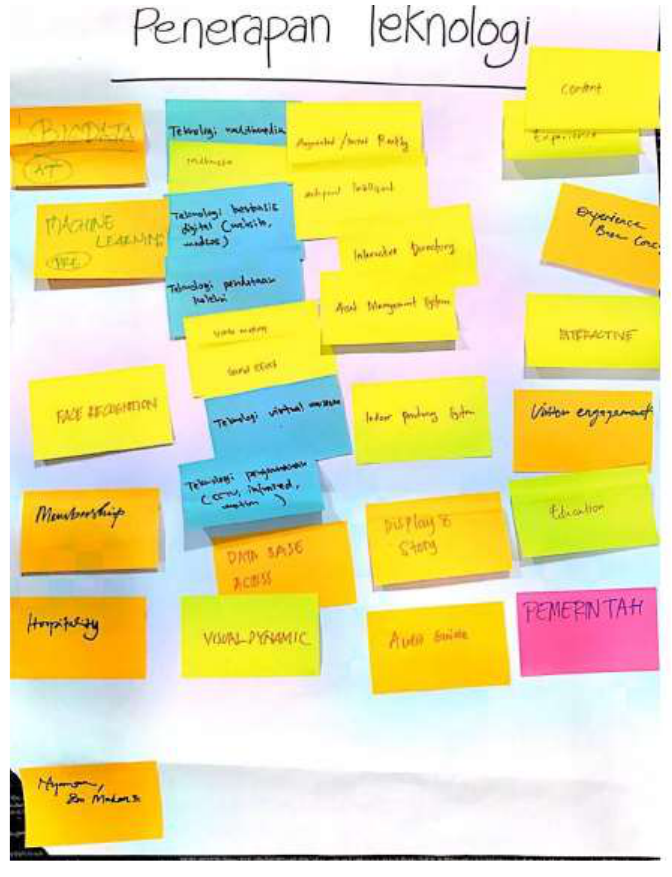
Figure 2. Types of Technology Application (FGD Summary)